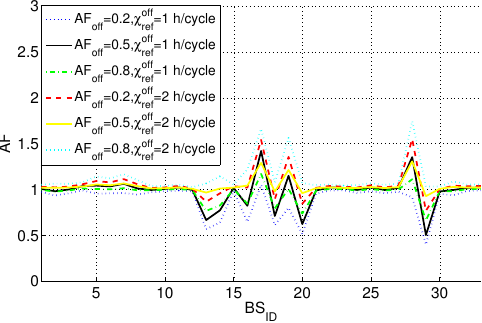
Figure 5. AF for the single BSs in the network.